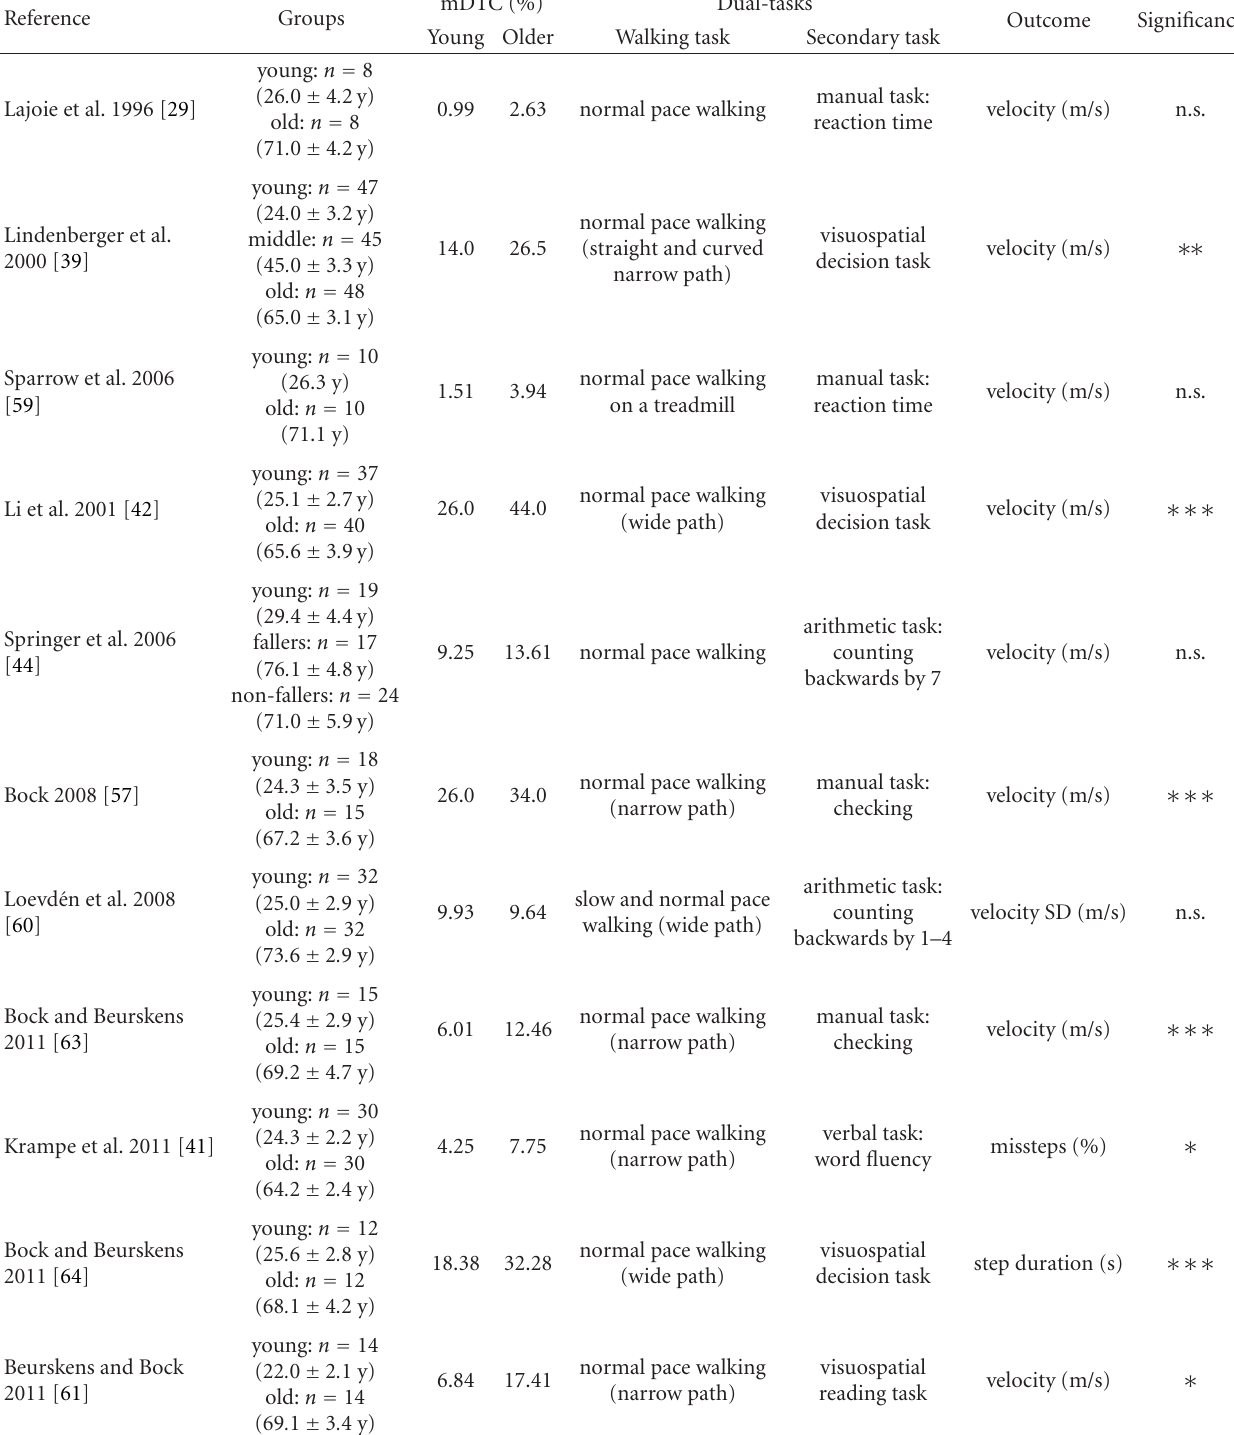
Table 1: Summary of main characteristics of the studies included in this